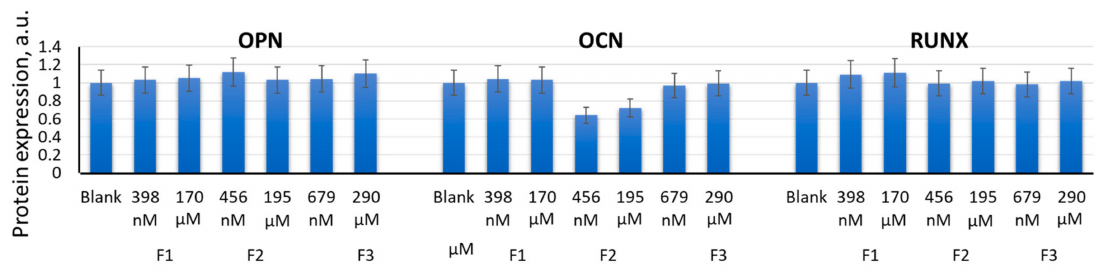
Figure 10. The effect of F1, F2, and F3 on the osteogenic differentiation proteins; the concentrations are shown in the figure. FL1 values were calculated for three experiments related to the blank. In blank experiments, cells were incubated without the